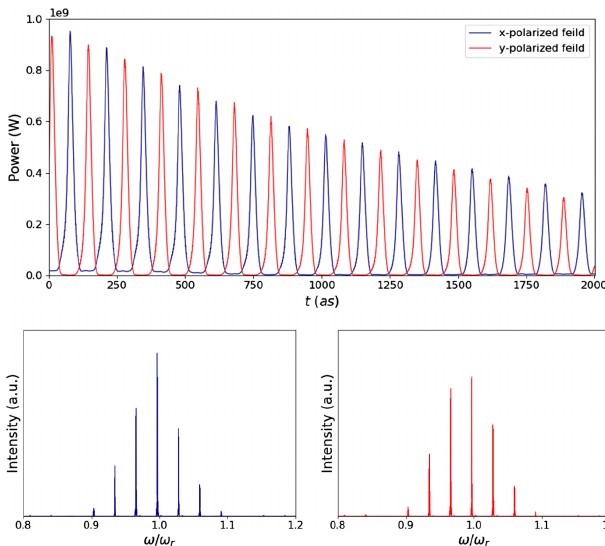
FIG. 2. Top: power vs relative time t for the x and y polarized fields and Bottom: the corresponding spectra after 36 undulator- chicane modules.